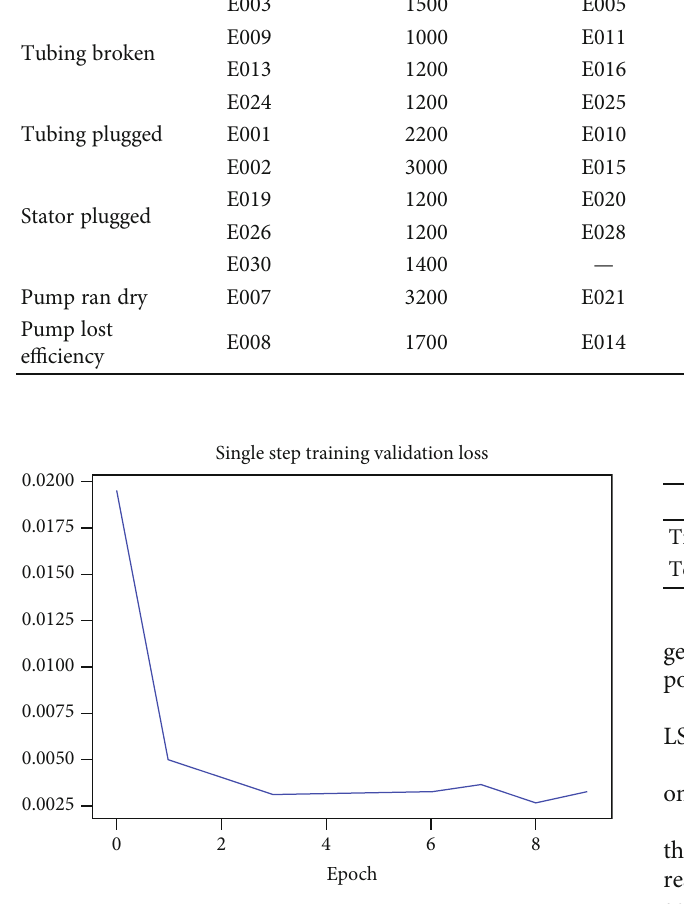
Figure 11: Change curve of training set loss with training times.